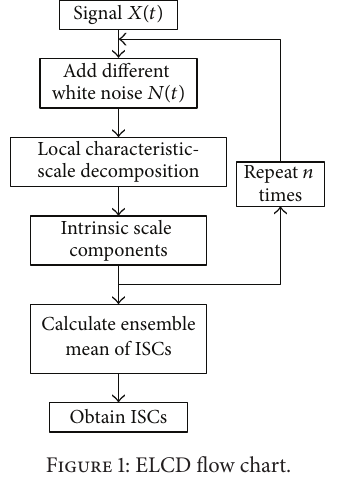
Figure 1: ELCD flow chart.